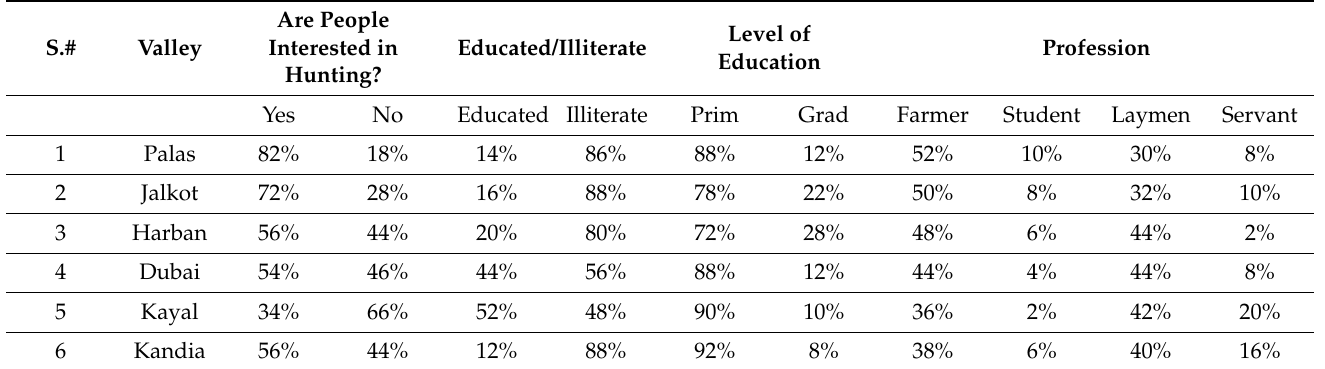
Table 5. Information regarding hunters, their level of education, and profession was collected from the surveys.